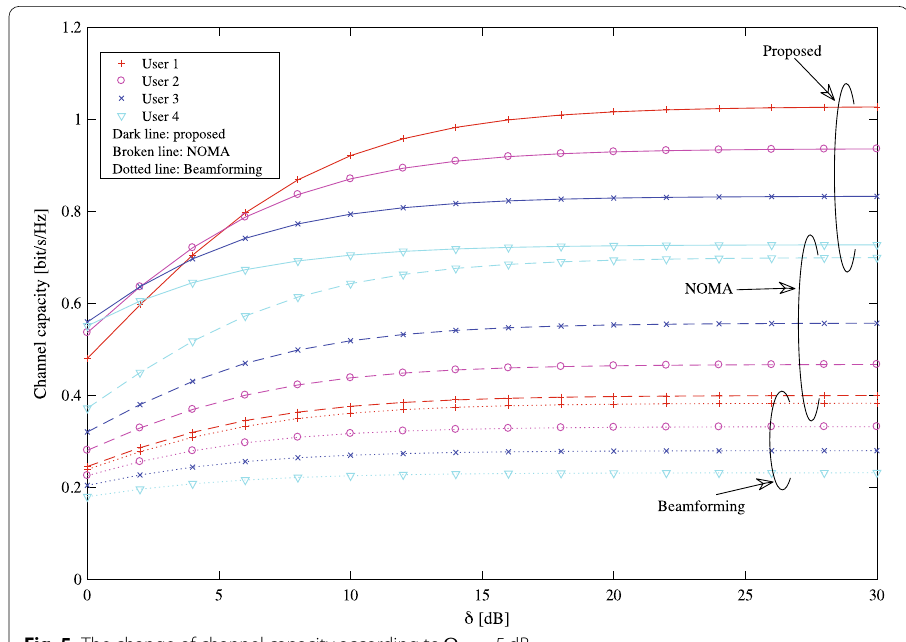
Fig. 5 The change of channel capacity according to (cid:31) K =